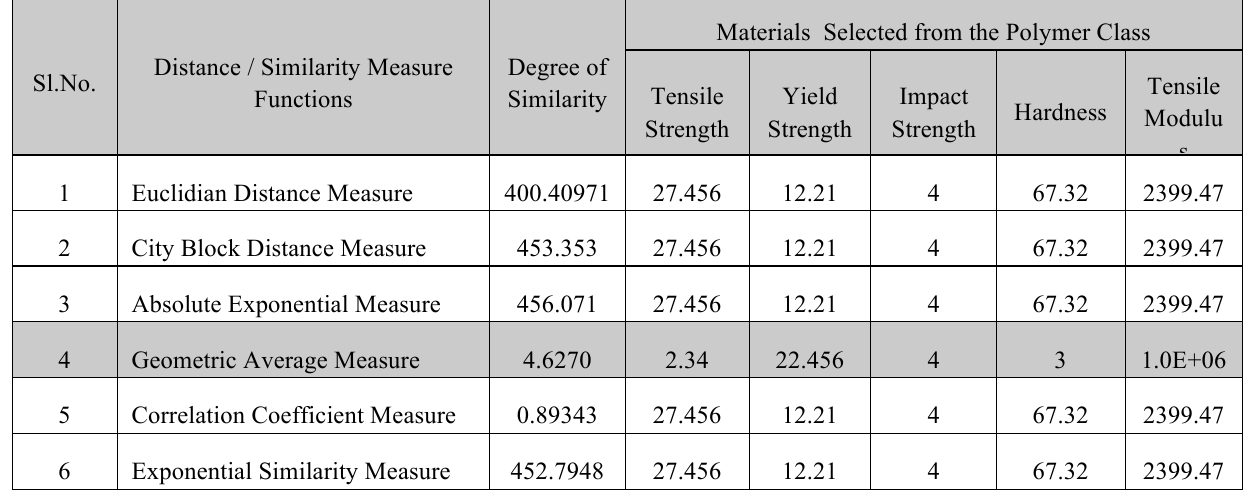
Table 2: Degree of similarity and materials selected from the Polymer class by different distance measuring functions